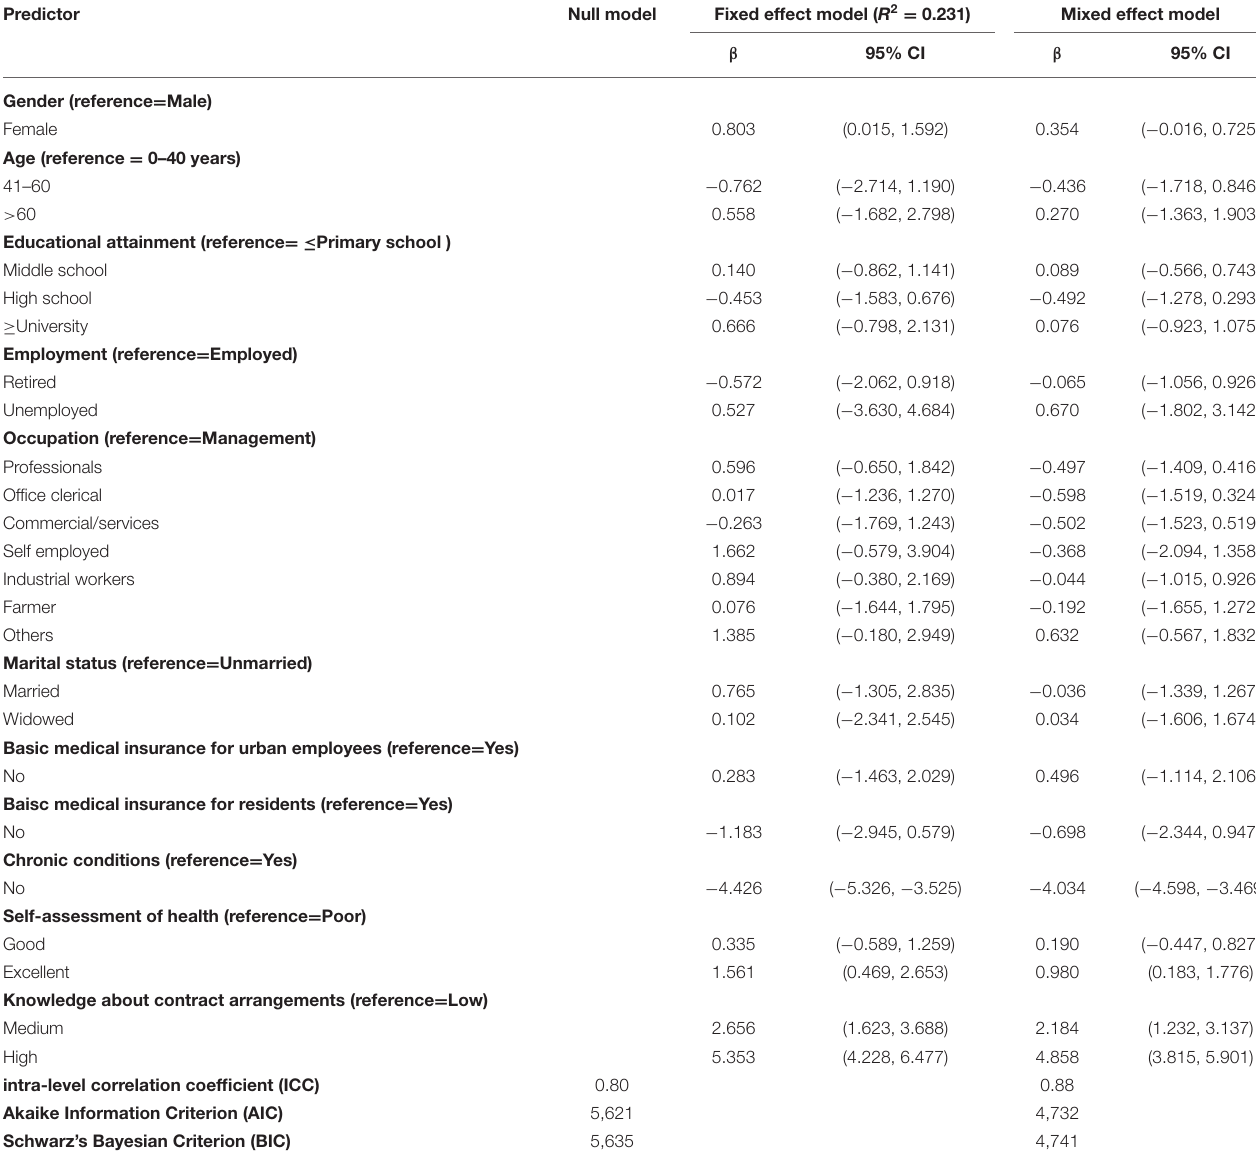
TABLE 5 | Multivariate linear regression analysis on factors associated with consumer